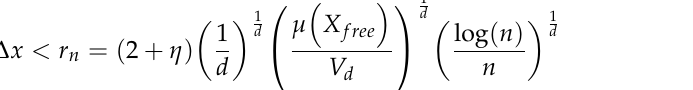
Table 2. DH parameters of the robot.